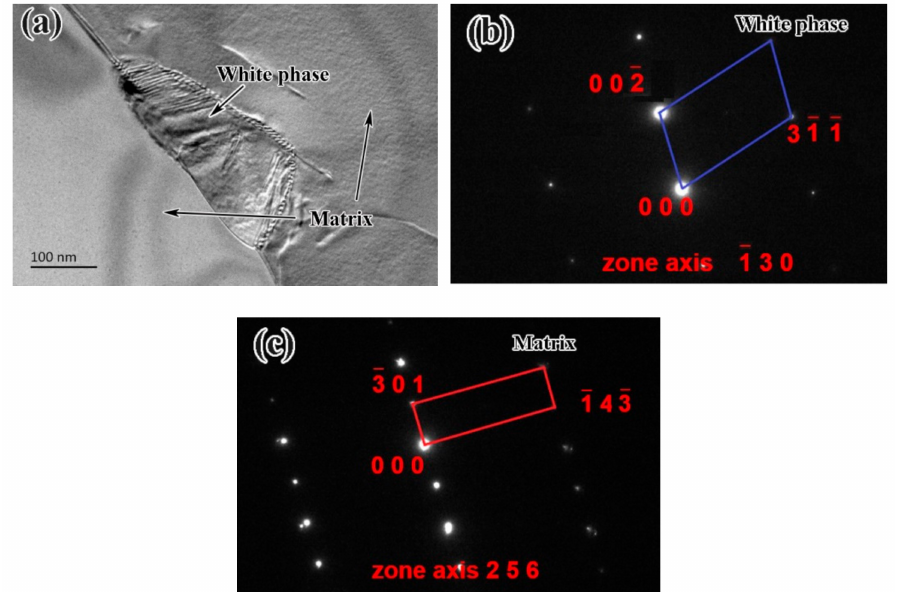
Figure 8. TEM images of the white precipitate phase in the GO/TiAl composites. ( a ) high resolution of white phase. ( b ) diffraction spot calibration of white phase. ( c ) and